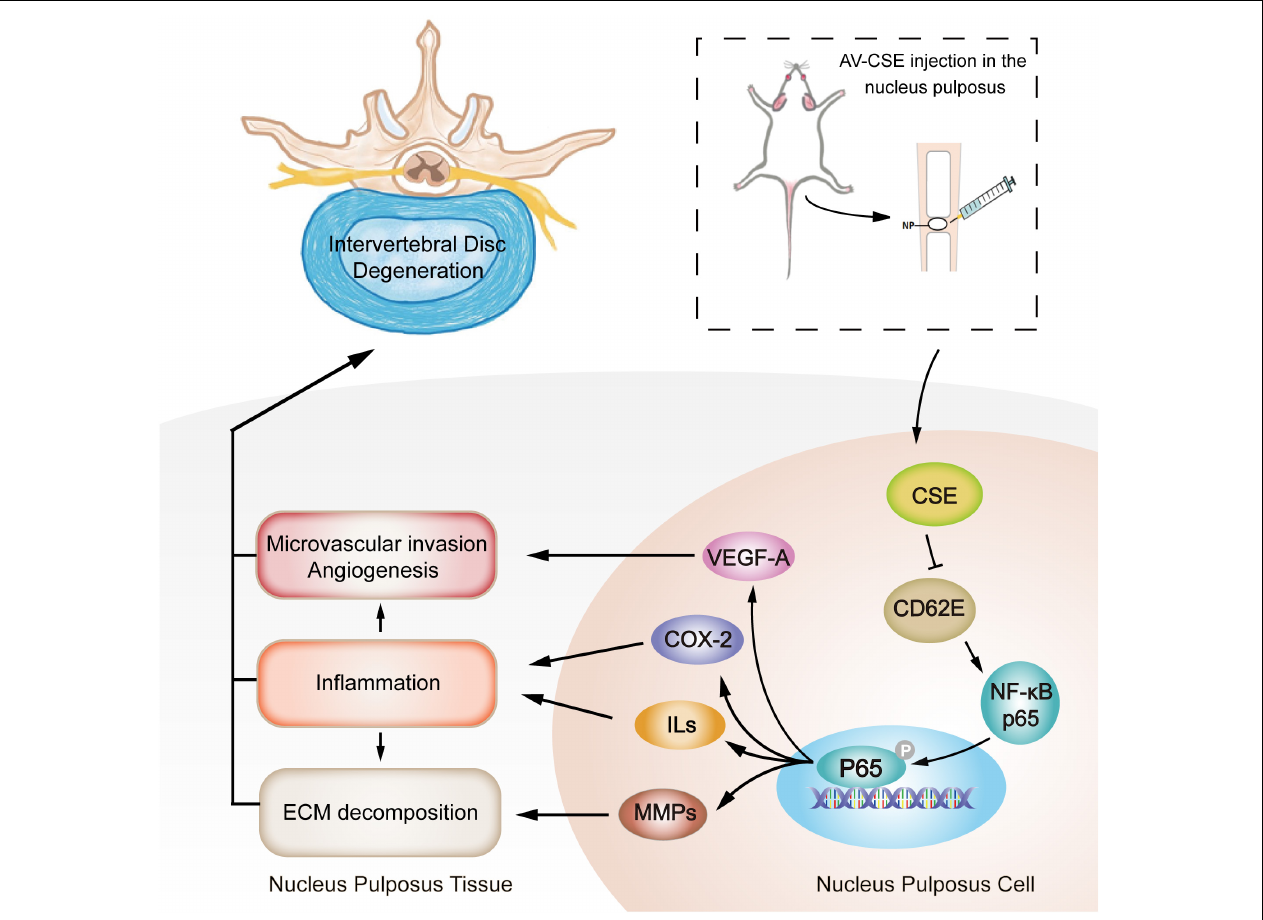
FIGURE 9 | Schematic illustration of mitigation of inflammation, microvascular invasion, and ECM decomposition in IDD progression mediated by AV-CSE treatment.